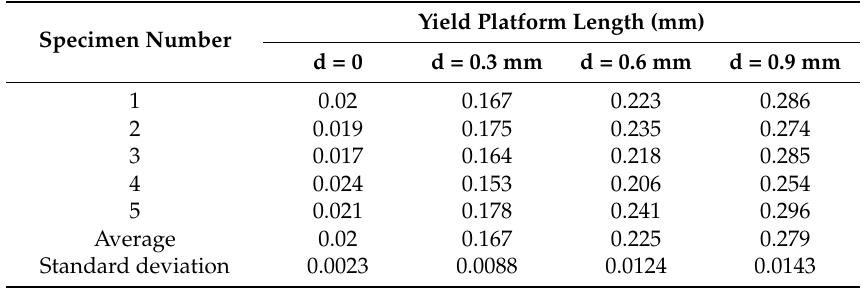
Table 6. Yield platform length of unpinned Cf/Al composites and z-pinned Cf/Al composites using stainless steel pins with a volume fraction of 1% measured/determined by short-beam shear